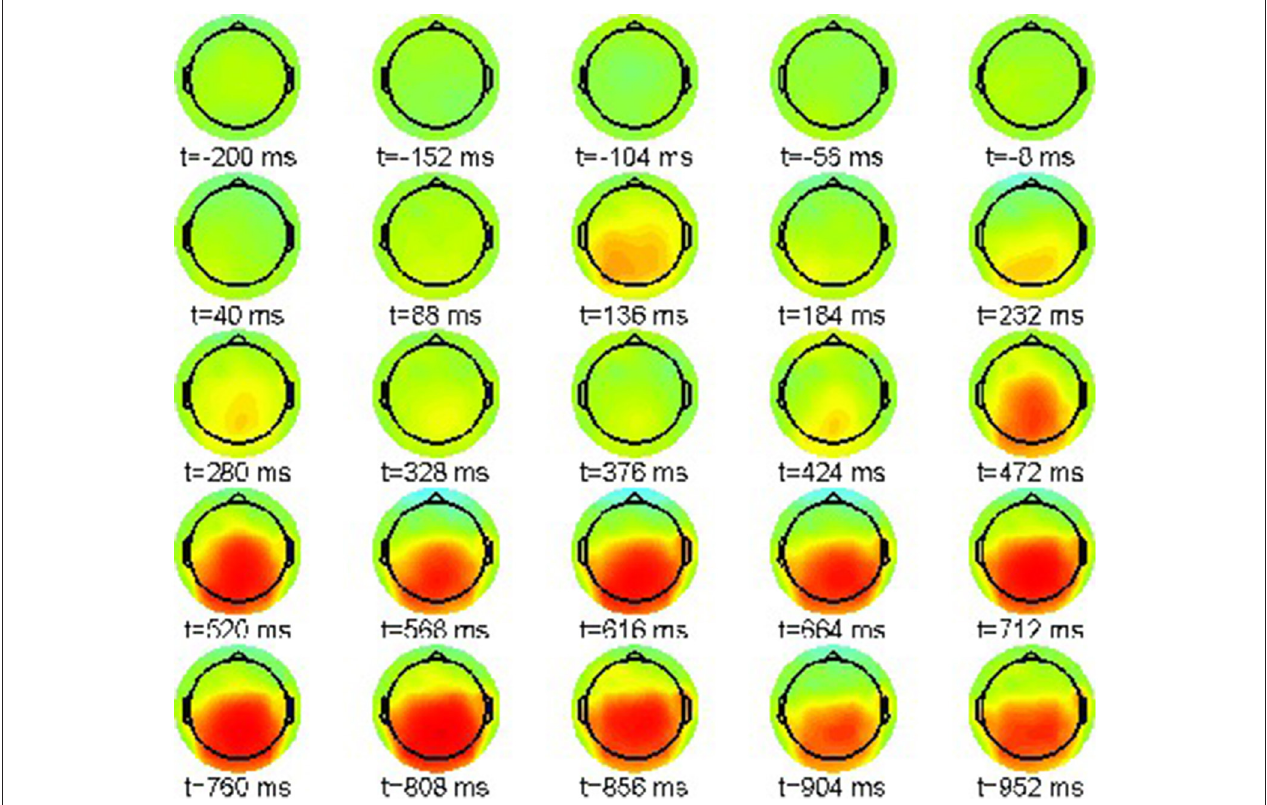
FIGURE 3 | Snapshot sequence of ERP scalp topographies for difference potential, cf. movie data.gif in Supplementary Material.